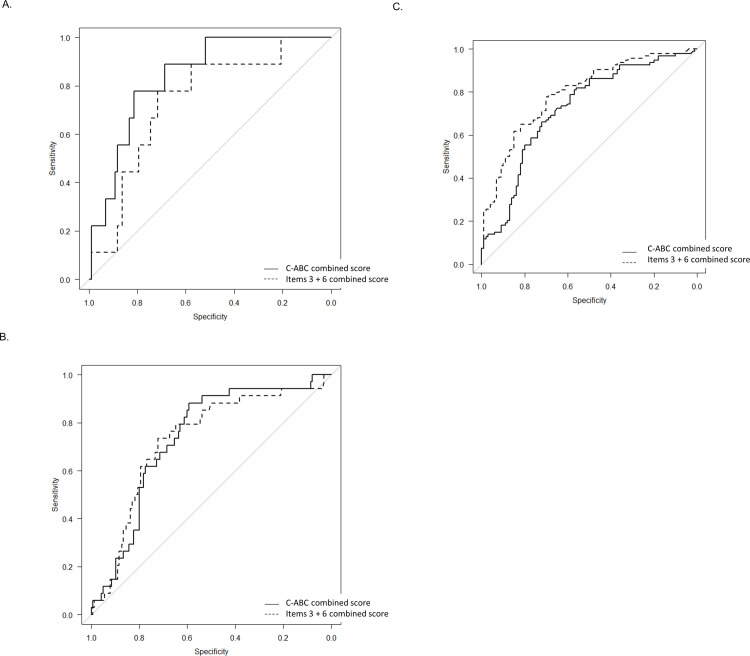
The ROC curves to distinguish MCI from NC in the 50s group (A), 60s group (B) and 70–85 group (C). Straight line, the C-ABC combined score; dotted line, the Item 3 + 6 combined score. C-ABC, computerized assessment battery for cognition; MCI, mild cognitive impairment; NC, normal cognition; ROC, receiver-operating characteristic.